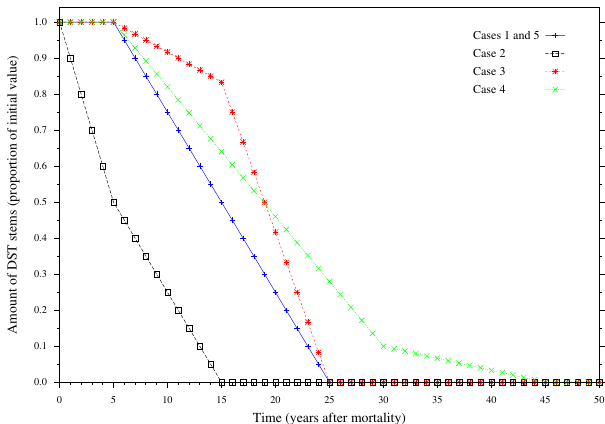
Figure 1. Litterfall schedule of DST stems for the five cases cur- rently implemented in MIM (see Table 2). Mortality happened in year 0 and all values are for the end of the corresponding